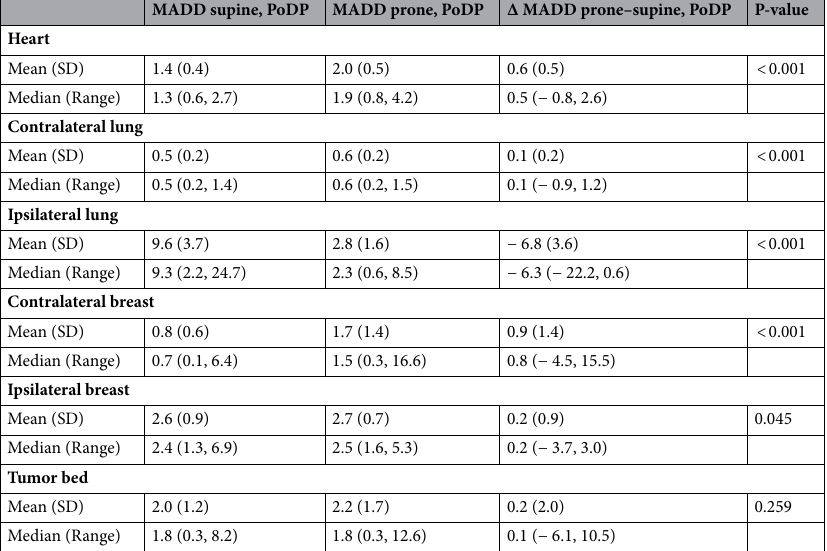
Table 2. Mean absolute dose deviation (MADD) by structure and setup. PoDP percent of dose